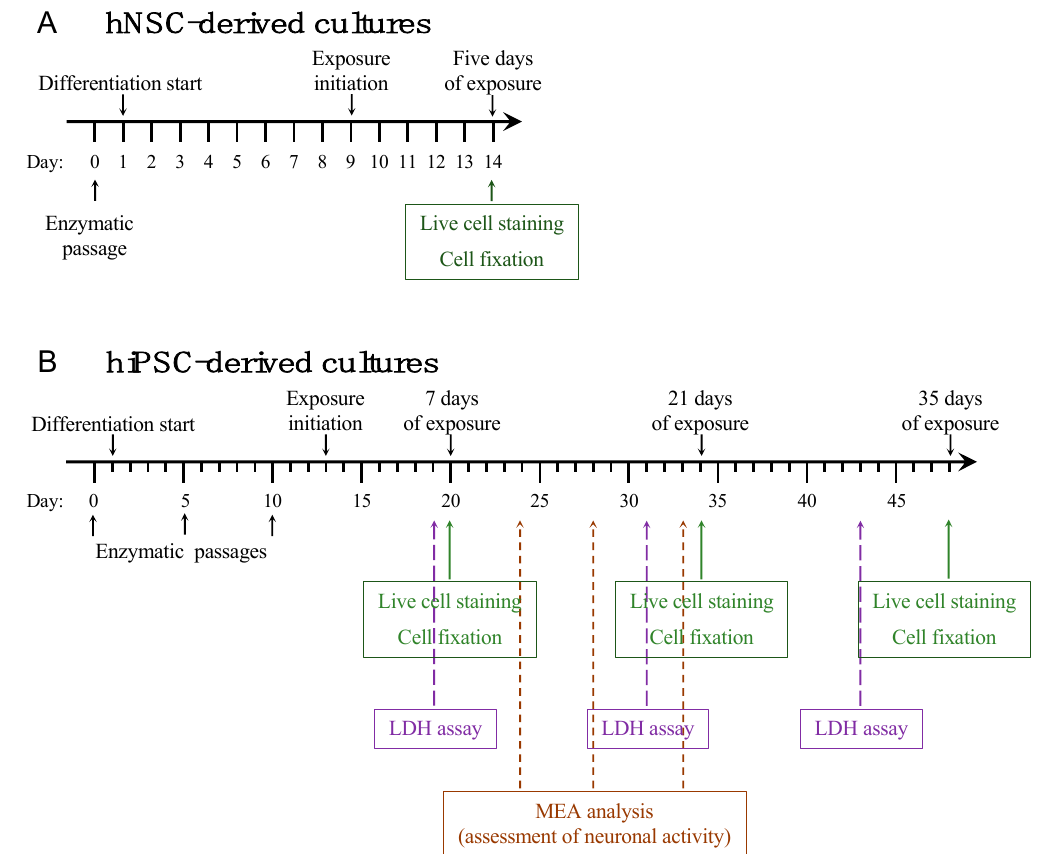
Figure 1. Graphical illustration of the experimental setup. Short-term autoantibody exposure was performed on human Neuronal Stem cells (hNSC) and the experimental setup is shown in panel ( A ). Long-term autoantibody exposure was performed on human-induced Pluripotent Stem Cell (hiPSC)-derived neurons and the experimental setup is shown in panel ( B ). Black arrows and text specify differentiation procedures. Colored arrows and text boxes specify the time points at which different analyses were performed. LDH: lactate dehydrogenase, MEA: multi electrode array.